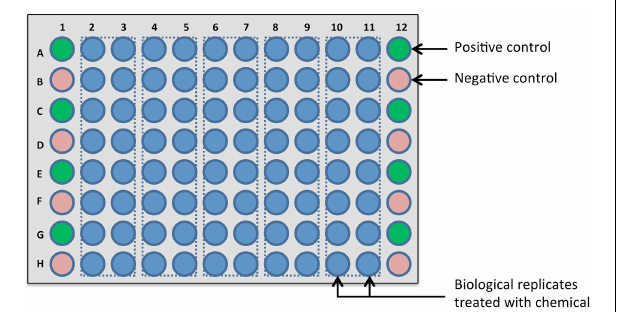
of a 96-well microplate (blue circles), allowing 40 chemicals to be analyzed. This design is recommended, because in commercial compound libraries, 80 different compounds are generally stored in the middle of 96-well plates and the first and last columns are left empty. Correspondingly, column 1 and column 12 are available for controls and to minimize edge-related bias, the eight positive controls (green circles) and the eight negative controls (red circles) are distributed across these columns in alternating